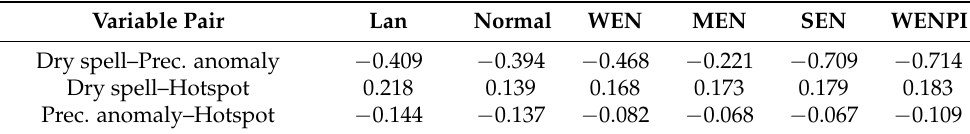
Table 2. Measure of association between each variable pair from 2001–2020 data of Southern Sumatra. Variable Pair Lan Normal WEN MEN SEN WENPI Dry spell–Prec. anomaly